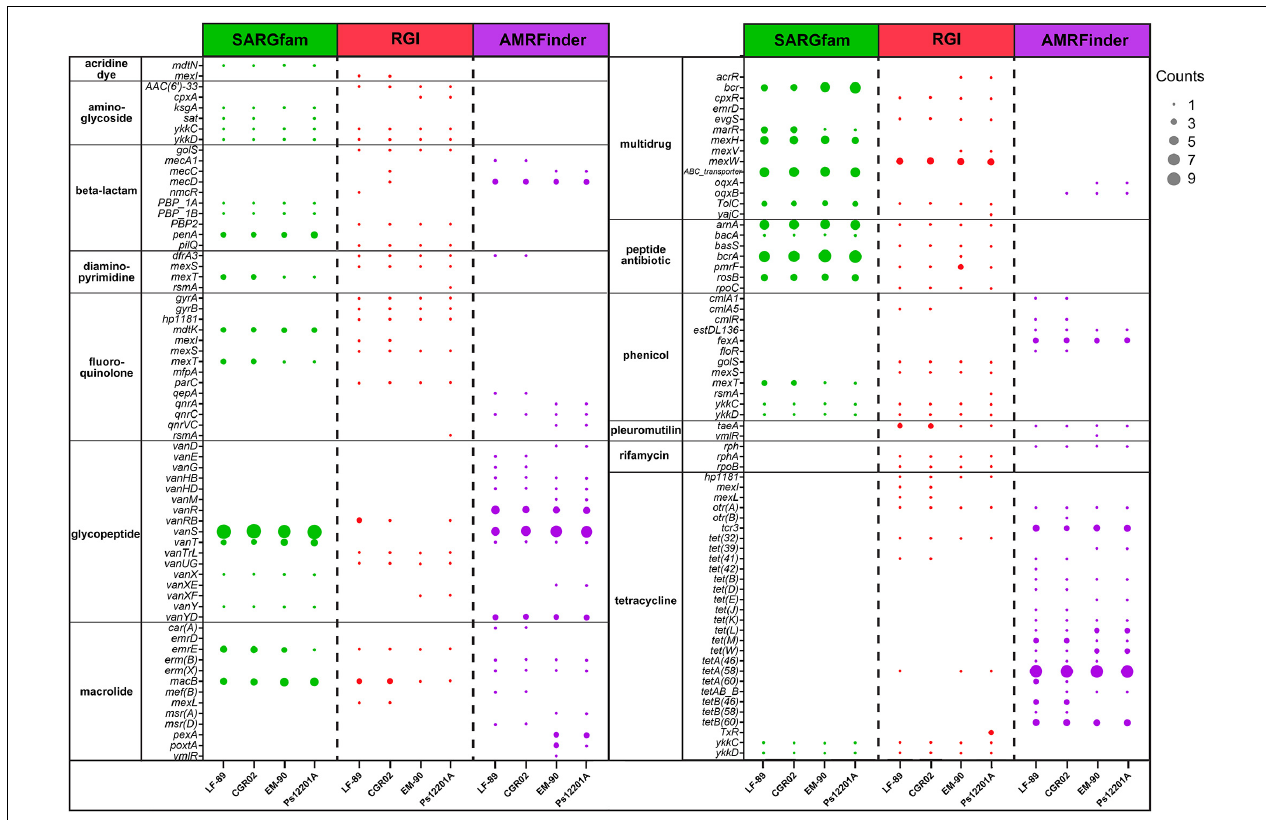
FIGURE 3 | Drug class of predicted ARGs. The number of identified genes for each drug class is shown for P. salmonis strains LF-89, CGR02, EM-90, and Ps12201A. The gene counts refer to the number of locus tag predicted with the same ARG name. Note that some ARGs were classified in more than one drug